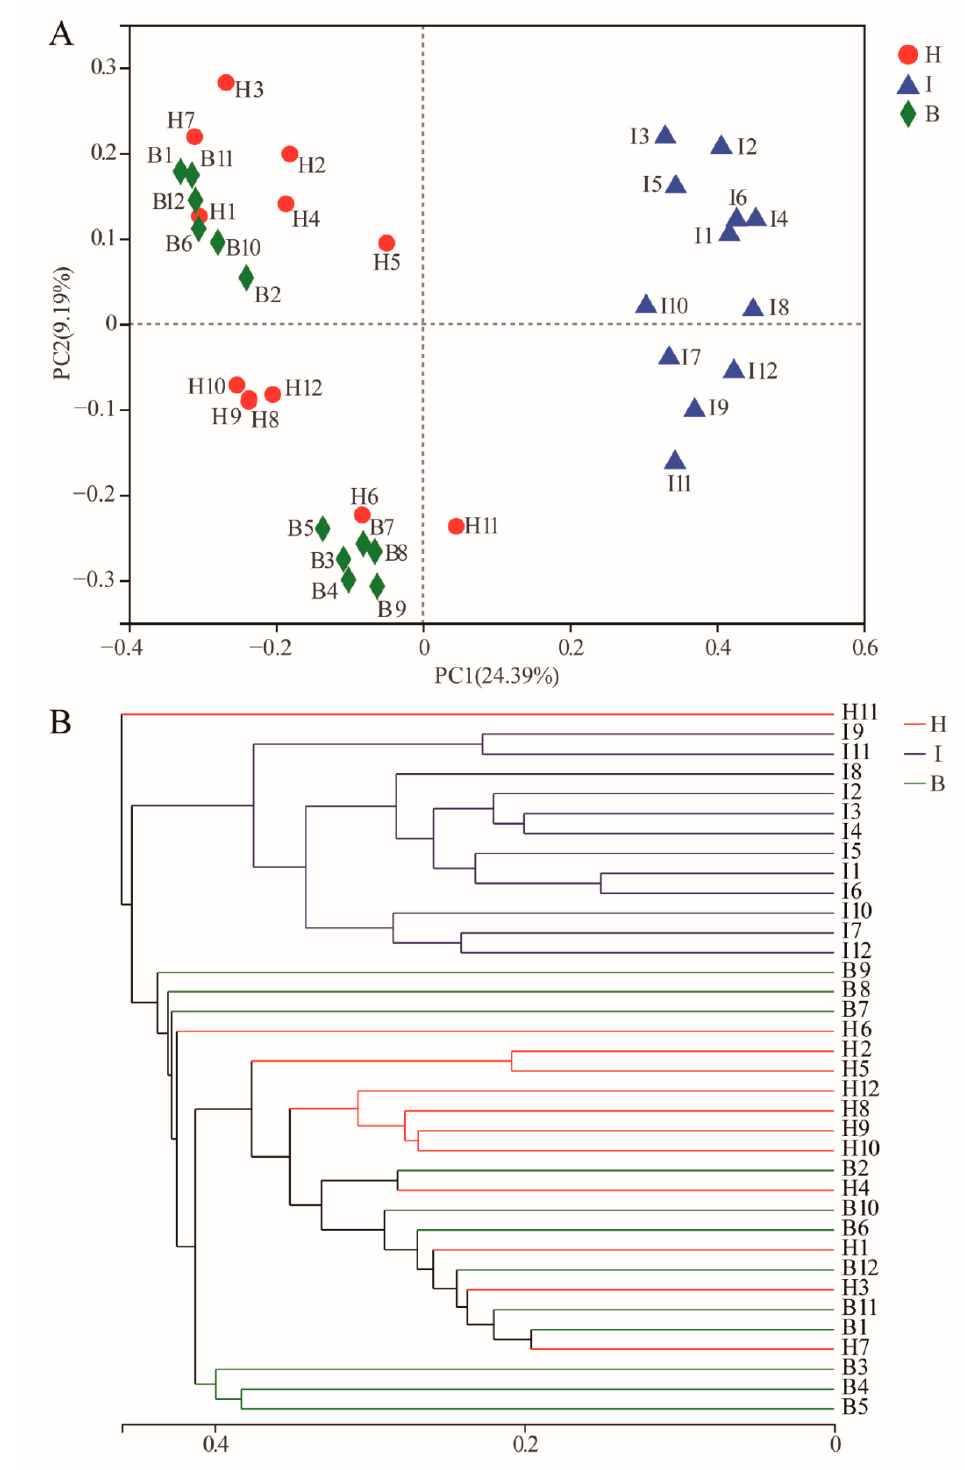
Figure 2. Analysis of the bacterial community structure at different sites. ( A ) Principal coordinate analysis based on the Bray ‐ Curtis metric of the bacterial communities. The percentages indicate the relative contribution of the principal components. ( B ) The taxonomic clustering tree based on Bray ‐ Curtis metric of the bacterial communities. B: hemolymph (B1–B12); H: hepatopancreas (H1–H12); I: intestine (I1–I12).